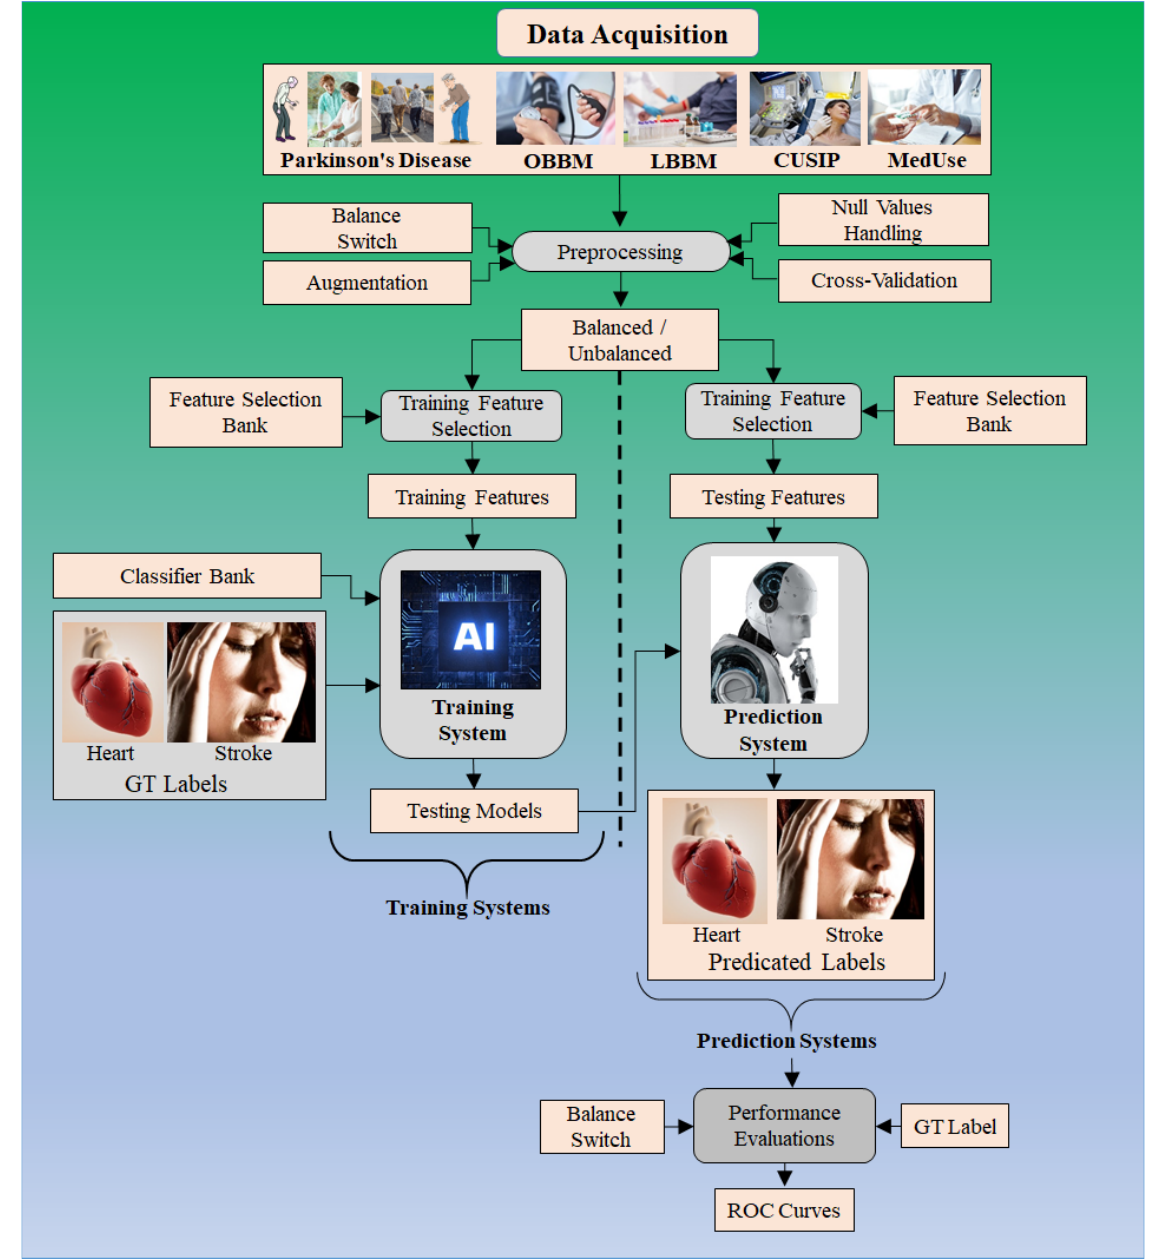
Figure 7. ML model for CVD/stroke risk assessment using Parkinson’s disease.